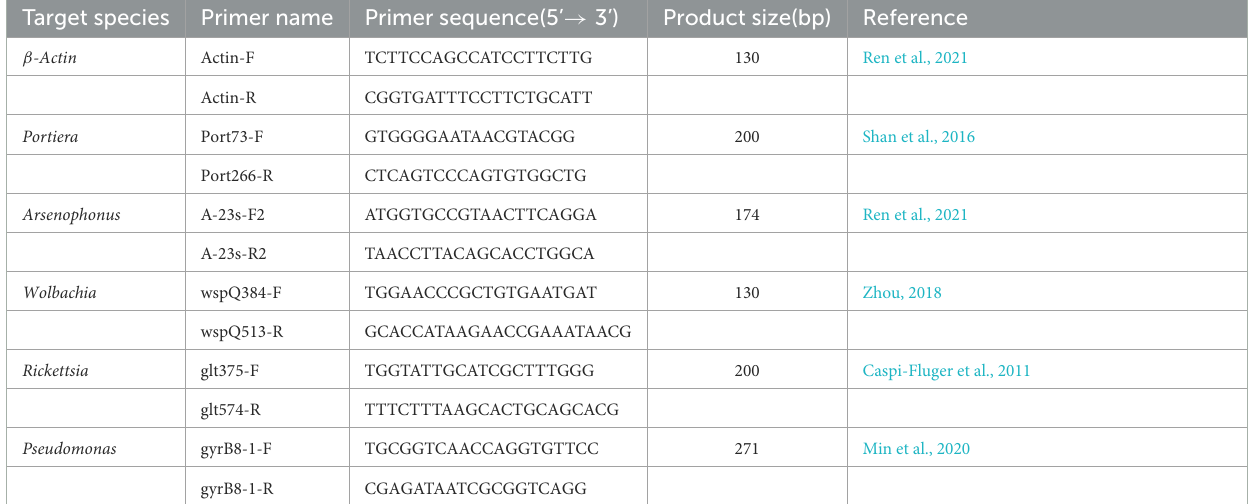
TABLE 1 Primers used in this real-time quantitative